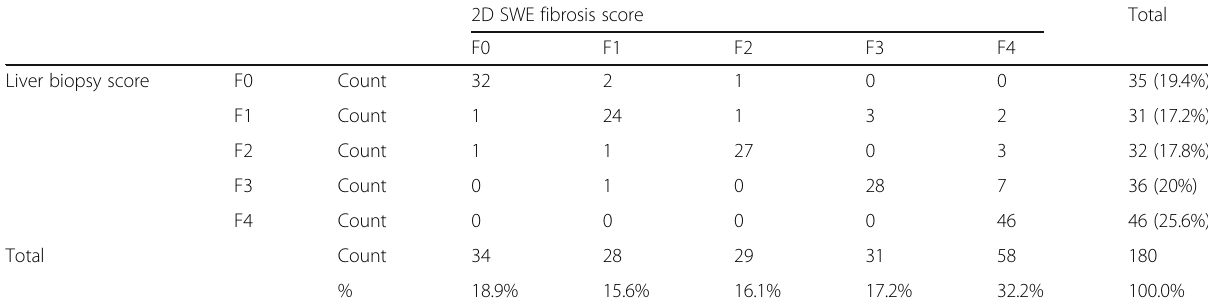
Table 3 The results of the SWE fibrosis score between the selected population compared to the tissue biopsy 2D SWE fibrosis score